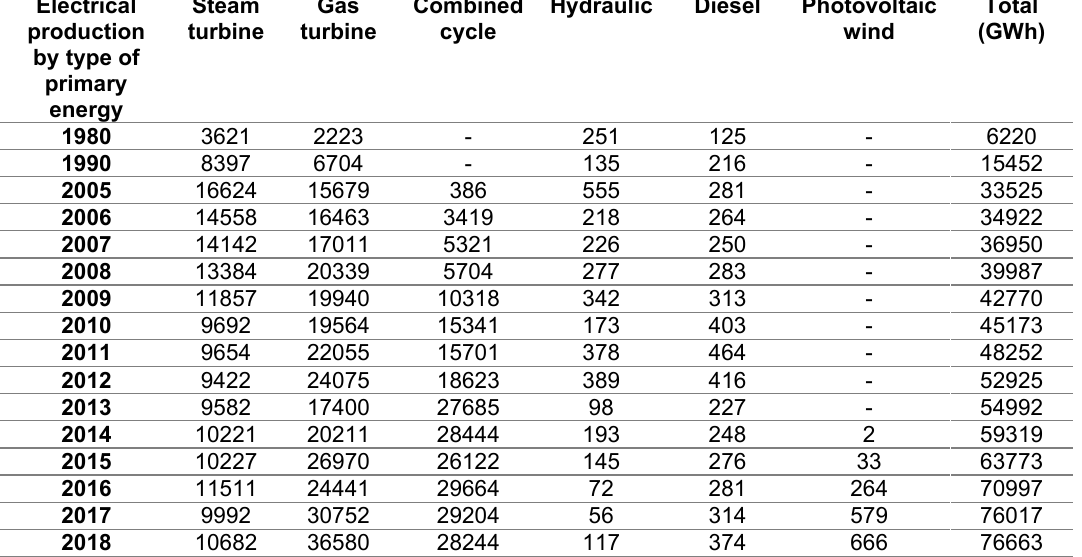
Figure 4. Algerian electricity network Table 6. Development and growth of conventional and renewable electric energy in Algeria between (1980-2018)